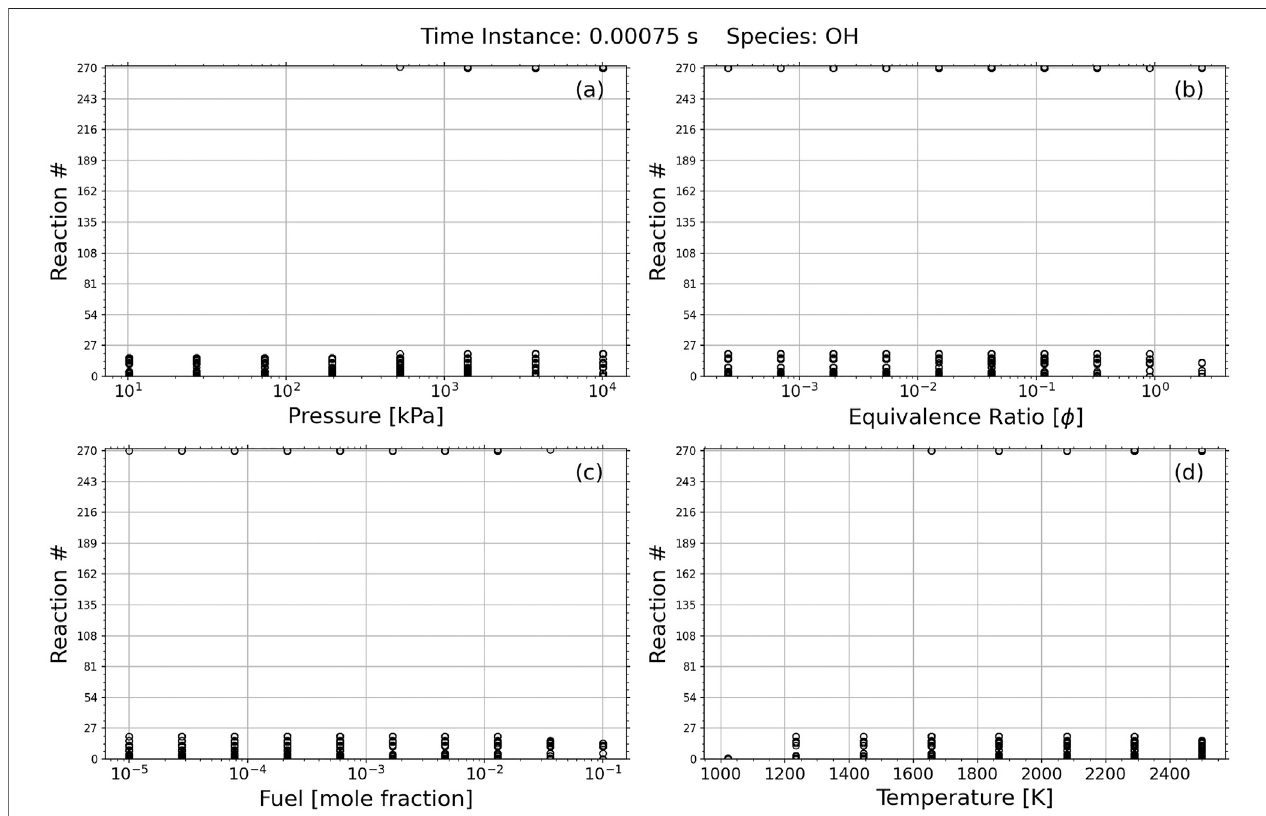
FIGURE 2 | Most Sensitive reactions of OH at 750 μ